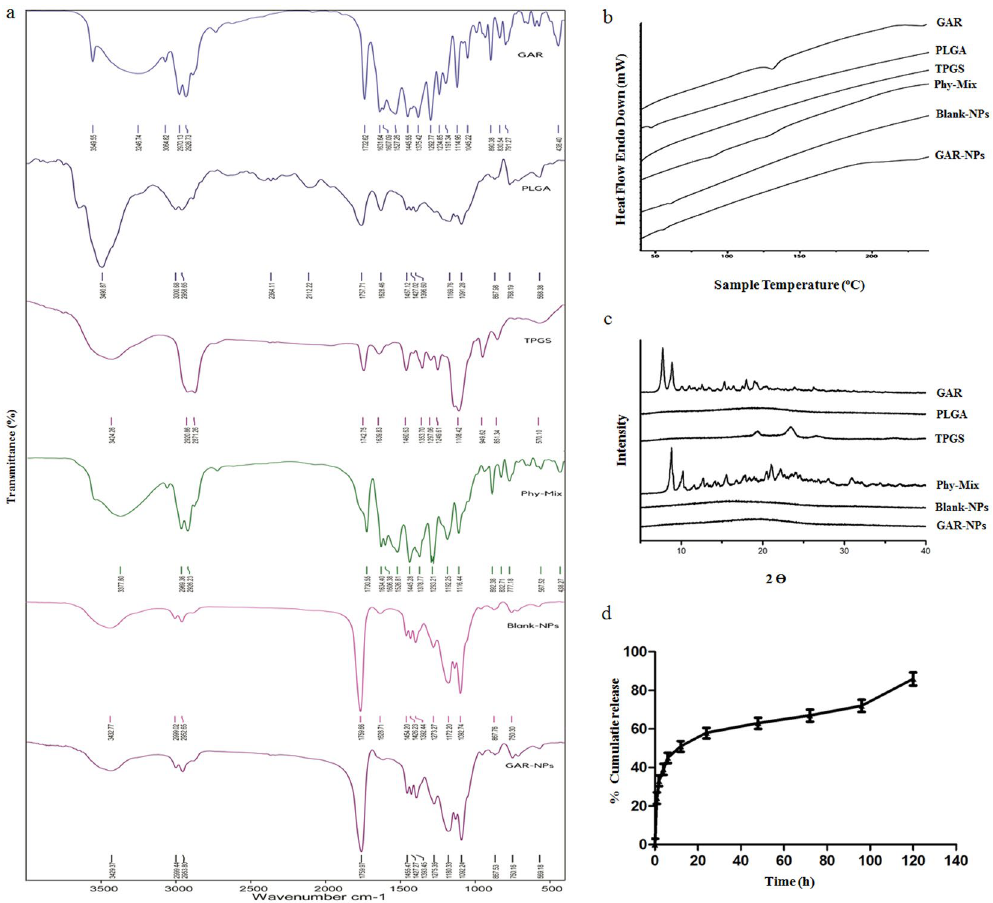
Figure 2. ( a ) FTIR spectra, ( b ) DSC thermograms and ( c ) XRD diffractograms of GAR, PLGA, TPGS, their phy-mix, blank-NPs and GAR-NPs. ( d ) In vitro drug release profile showing cumulative percent drug release of GAR-NPs vs